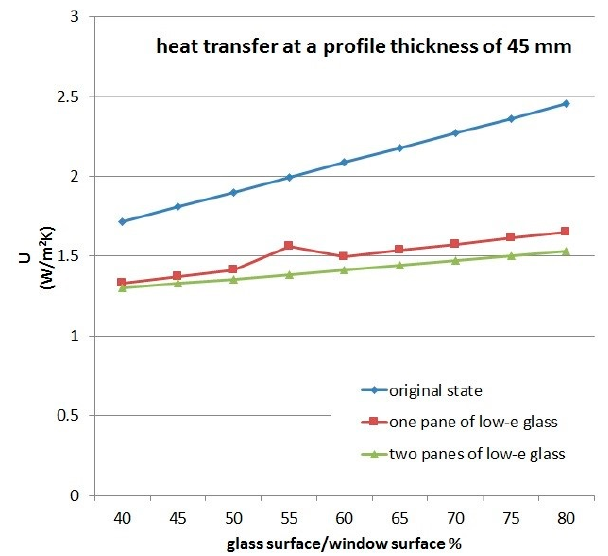
Figure 10. Heat transfer of windows in case of glass replacement with a gap surface of ≤ 500 mm 2 / rm calculated with the base data of [41].